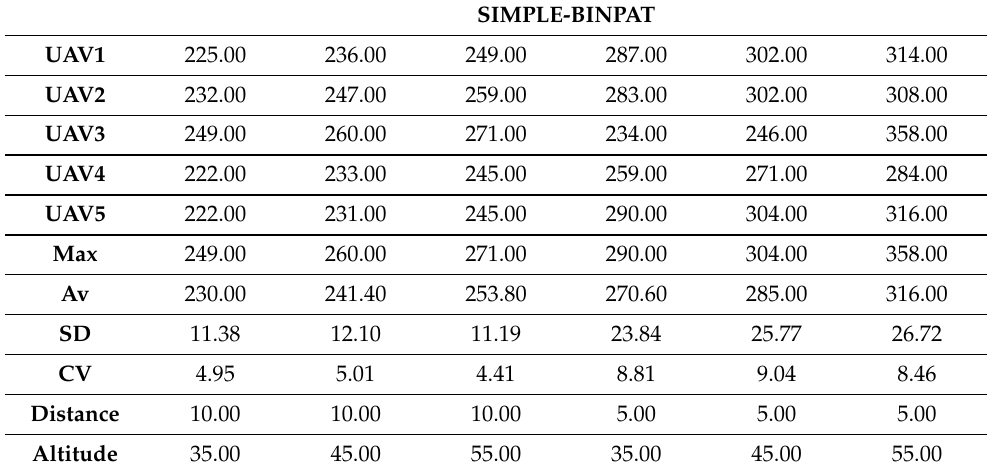
Table A4. Time results using the SIMPLE-BINPAT algorithm and five UAVs in a short-track scenario.